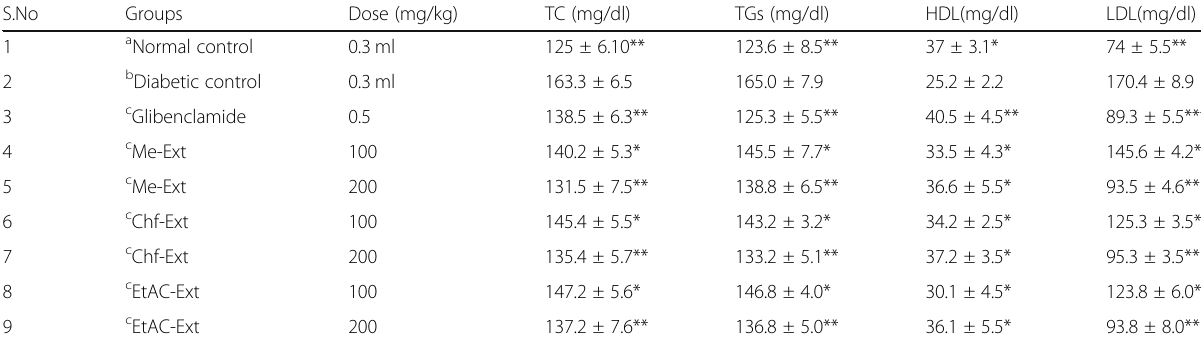
Table 5 Effect of E. umbellata fruit methanolic extract/fractions on lipid profile in streptozotocin induced diabetic rats S.No